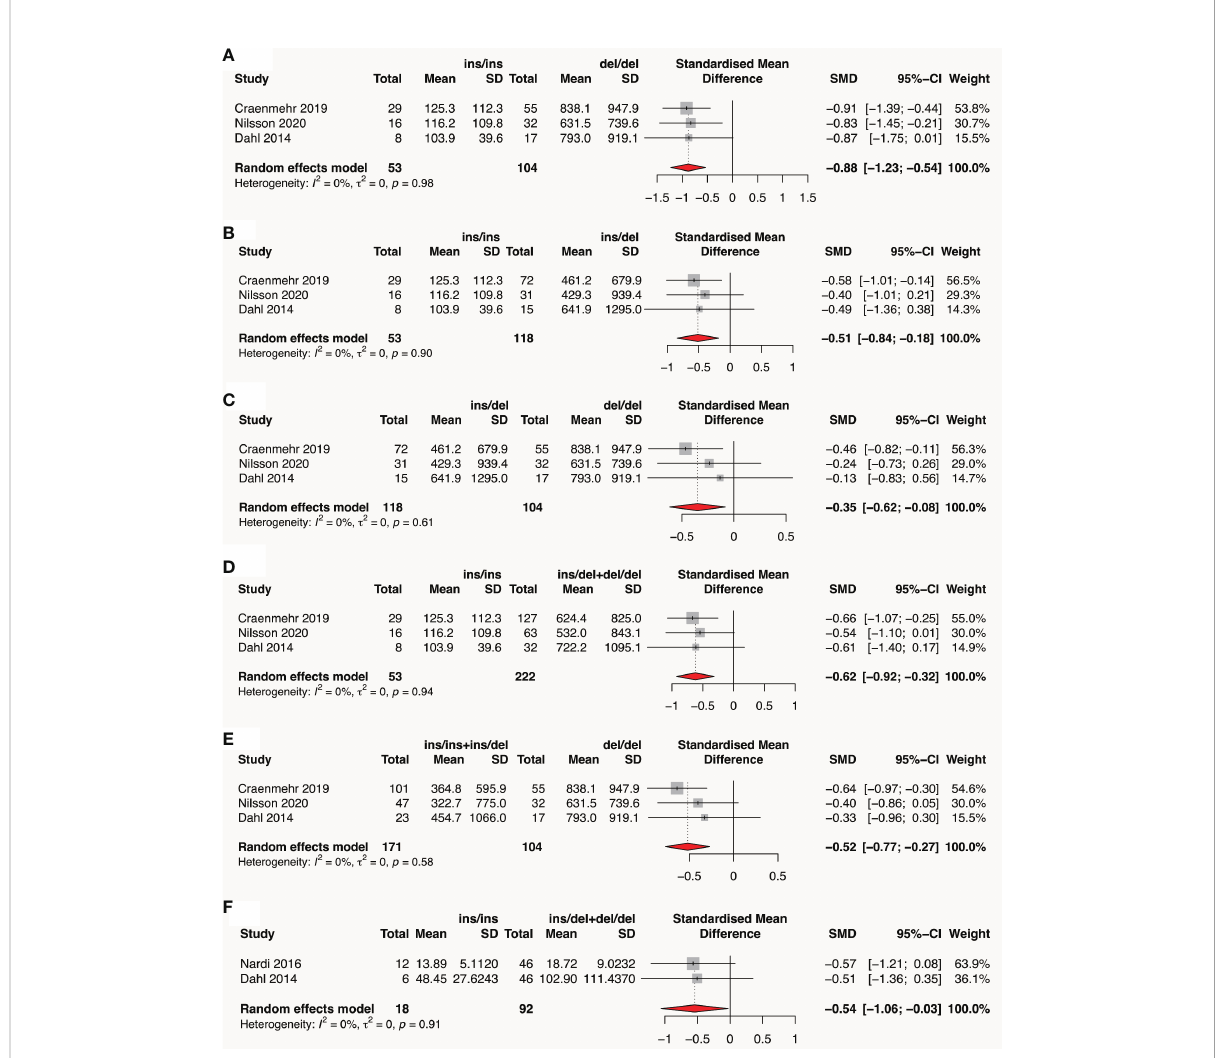
FIGURE 7 Forest plot showing the association of parental HLA-G 14bp ins/del polymorphism with sHLA-G expression in seminal plasma or in blood plasma. (A) Meta-analysis of sHLA-G expression in male seminal plasma in comparison of ins/ins genotype versus del/del genotype. (B) Meta- analysis of sHLA-G expression in male seminal plasma in comparison of ins/ins genotype versus ins/del genotype. (C) Meta-analysis of sHLA-G expression in male seminal plasma in comparison of ins/del genotype versus del/del genotype. (D) Meta-analysis of sHLA-G expression in male seminal plasma in comparison of ins/ins genotype versus ins/del+del/del genotype. (E) Meta-analysis of sHLA-G expression in male seminal plasma in comparison of ins/ins+ins/del genotype versus de/del genotype. (F) Meta-analysis of sHLA-G expression in female blood plasma in comparison of ins/ins genotype versus ins/del+del/del